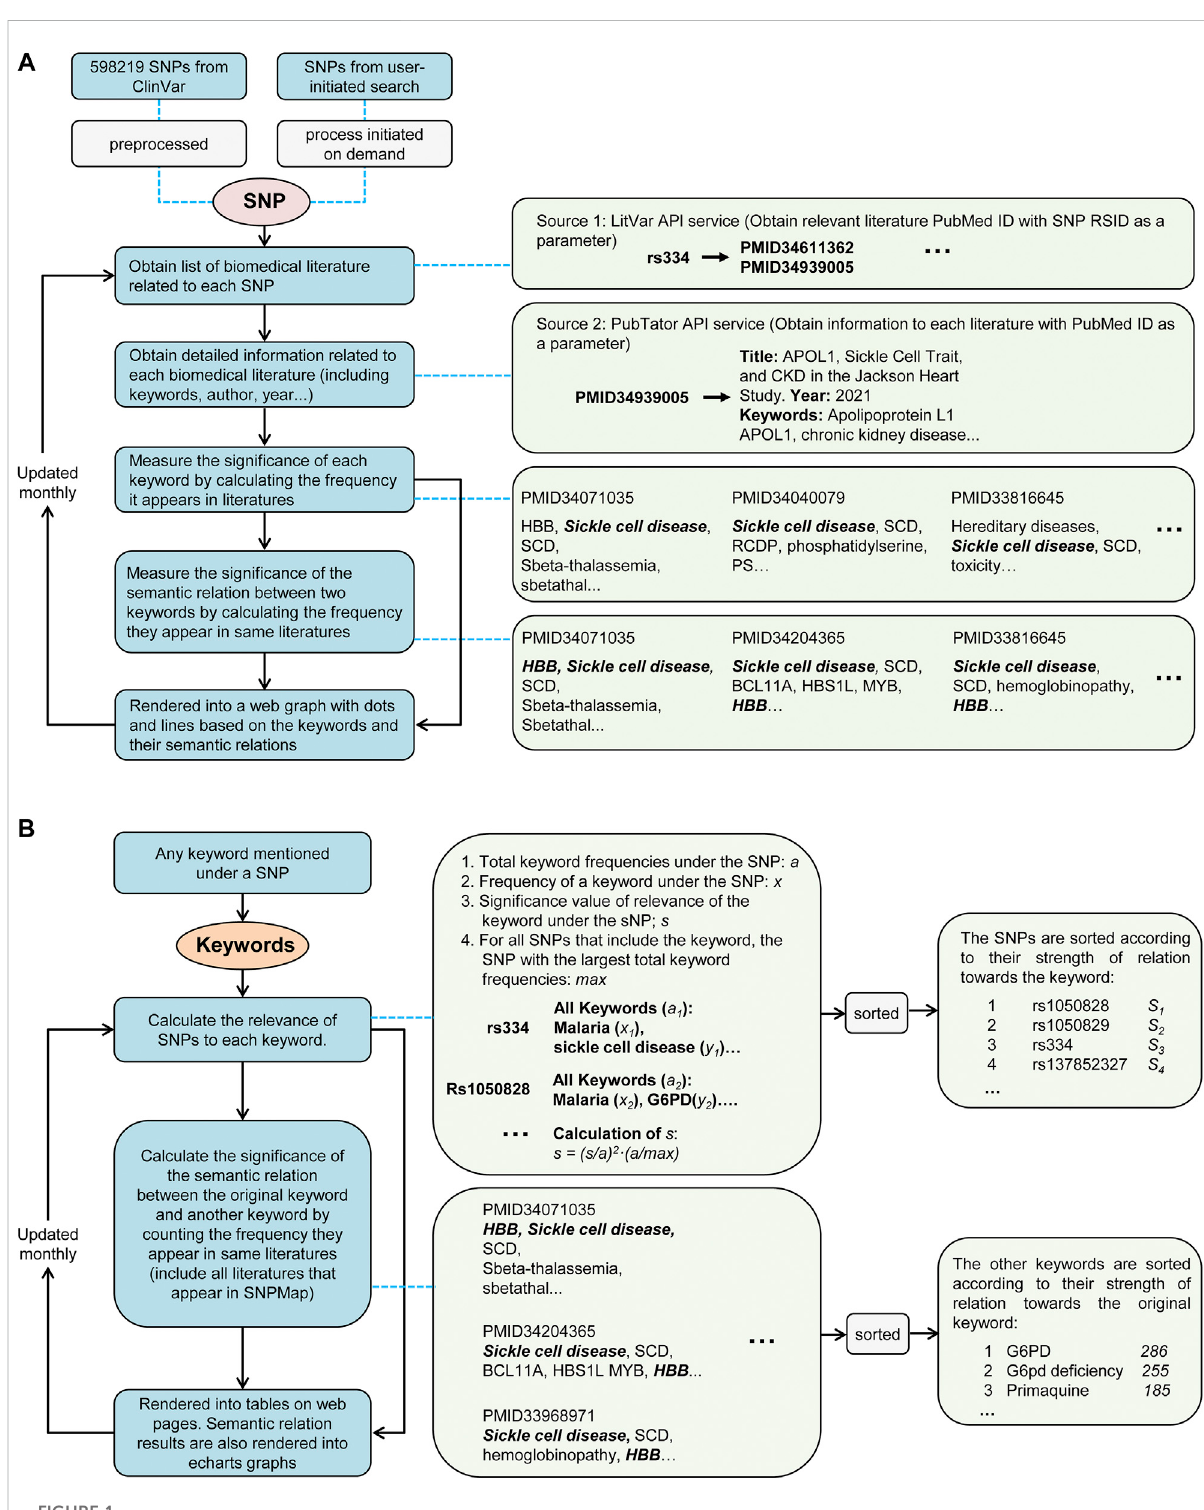
FIGURE 1 Thedataprocessingwork fl owofSNPMap. (A) TheprocessofobtainingkeywordinformationandrenderinggraphfromSNPs. (B) Theprocessof calculating SNP or external keyword connections of keywords mentioned in